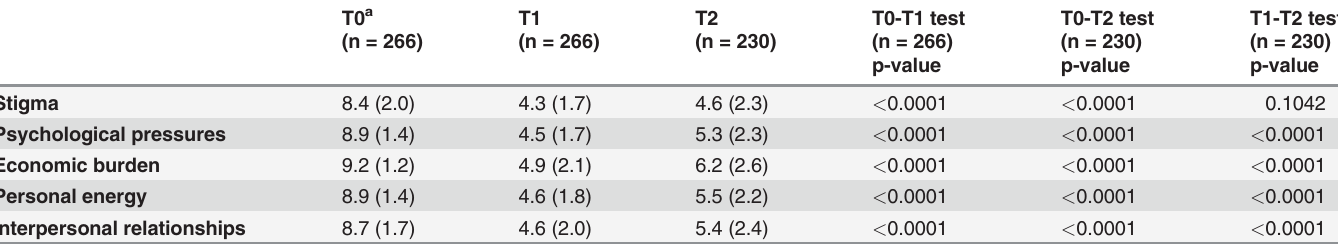
Table 4. Changes in family burden ratings (T0, T1 and T2